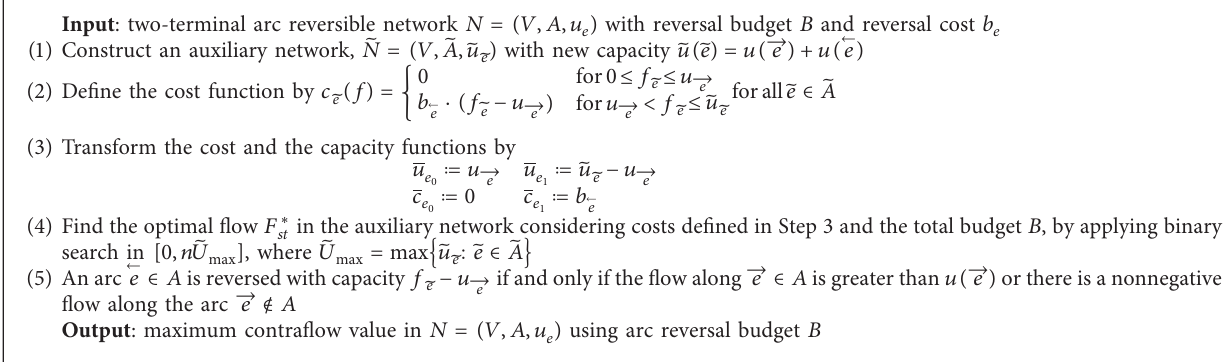
Input : two-terminal arc reversible network N � ( V, A, u e ) with reversal budget B and reversal cost b e